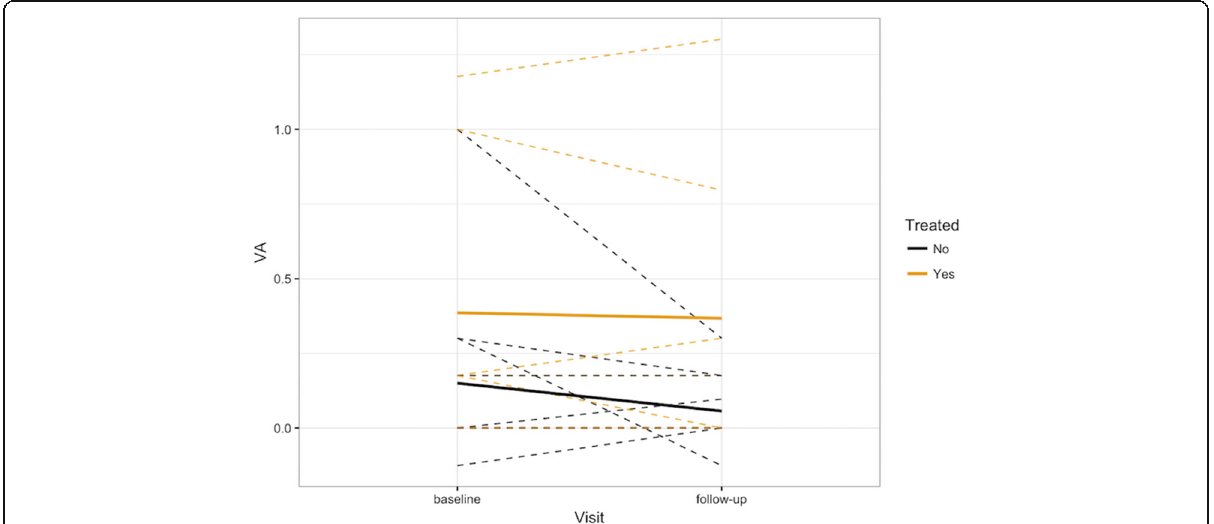
Fig. 9 Visual acuity at baseline and follow-up visits stratified by eyes that received treatment and eyes that were observed. The baseline VA is higher for treated patients compared to those who were not treated. There is no statistically significant difference in final visual acuity of treated eyes compared to those not